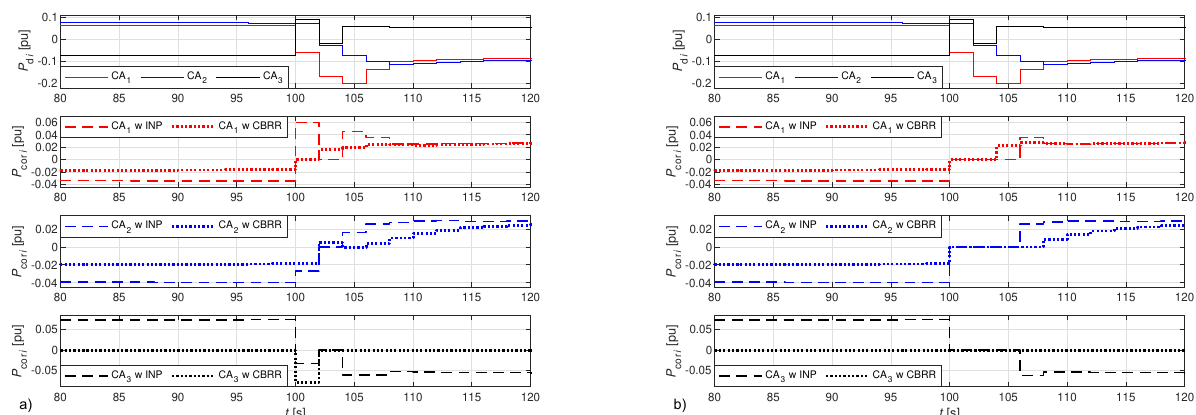
Figure 7. Time responses of P d i and P cor i for a three-CA testing system without P cor i adjustment ( a ) and with P cor i adjustment ( b ), where “w INP” is with the INP and “w CBRR” is with the